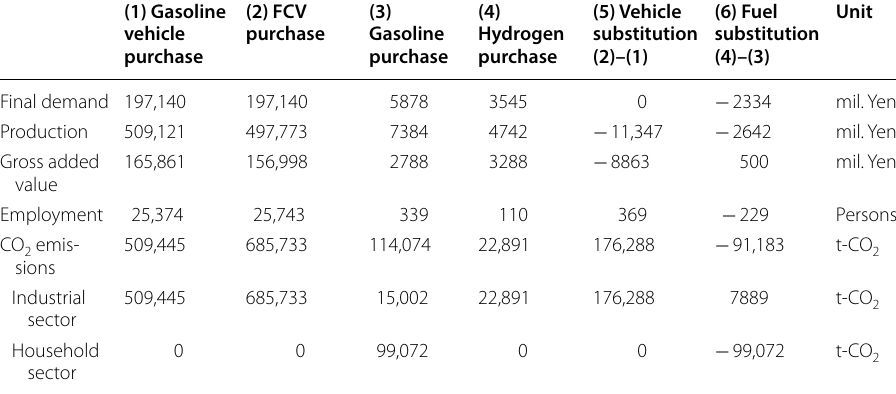
Table 10 Hydrogen production by steam reforming of methane method. Source : Authors’